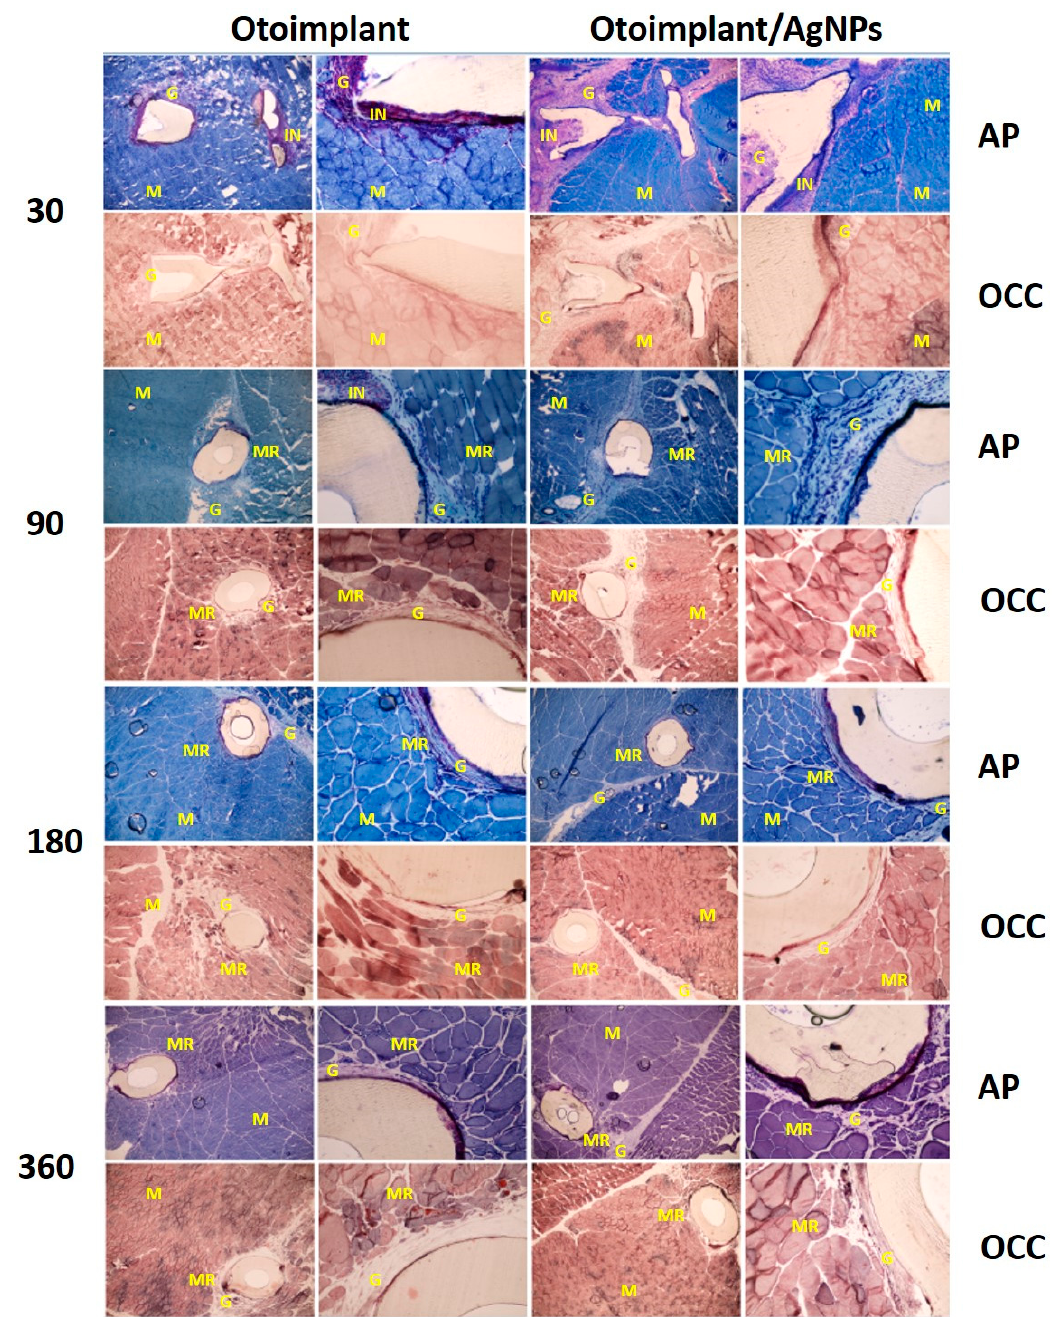
Figure 6. Cross-sections of tissues with otoimplant (on the left ) and otoimplant/AgNPs (on the right ) after 30, 90, 180 and 360 days of implantation in the rats’ muscles, acid phosphatase (AP) and cytochrome c oxidase (OCC) staining, objective 4, 20×. NOTE: The following symbols are used to describe the tissue cross-sections: M—muscle tissue, G—granulation tissue, IN—inflammatory infiltration, MR—regenerating muscle.